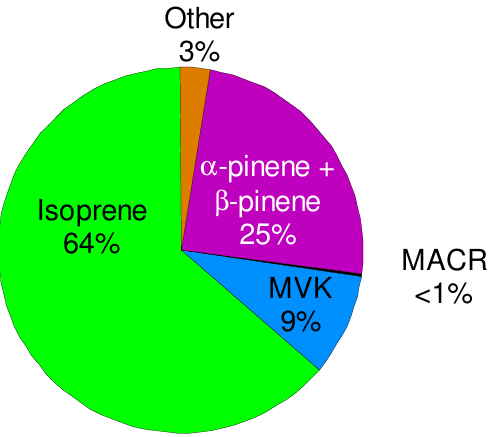
Fig. 4. Distribution of the instantaneous production rate of organic nitrates in the boundary layer over the remote boreal forest. Details of the calculation are described in Appendix